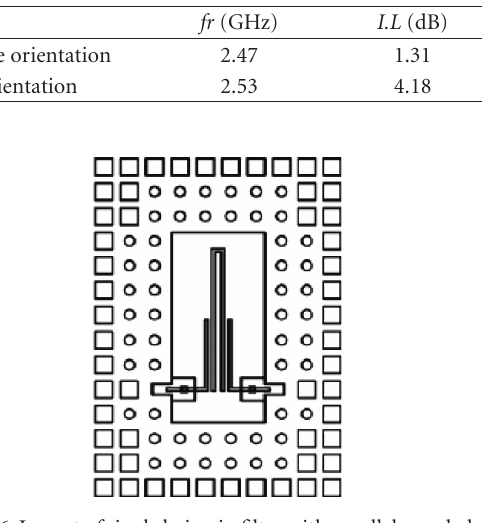
Figure 18: Single hair-pin resonator filter with (a) coupled-line feed and (b) loop.